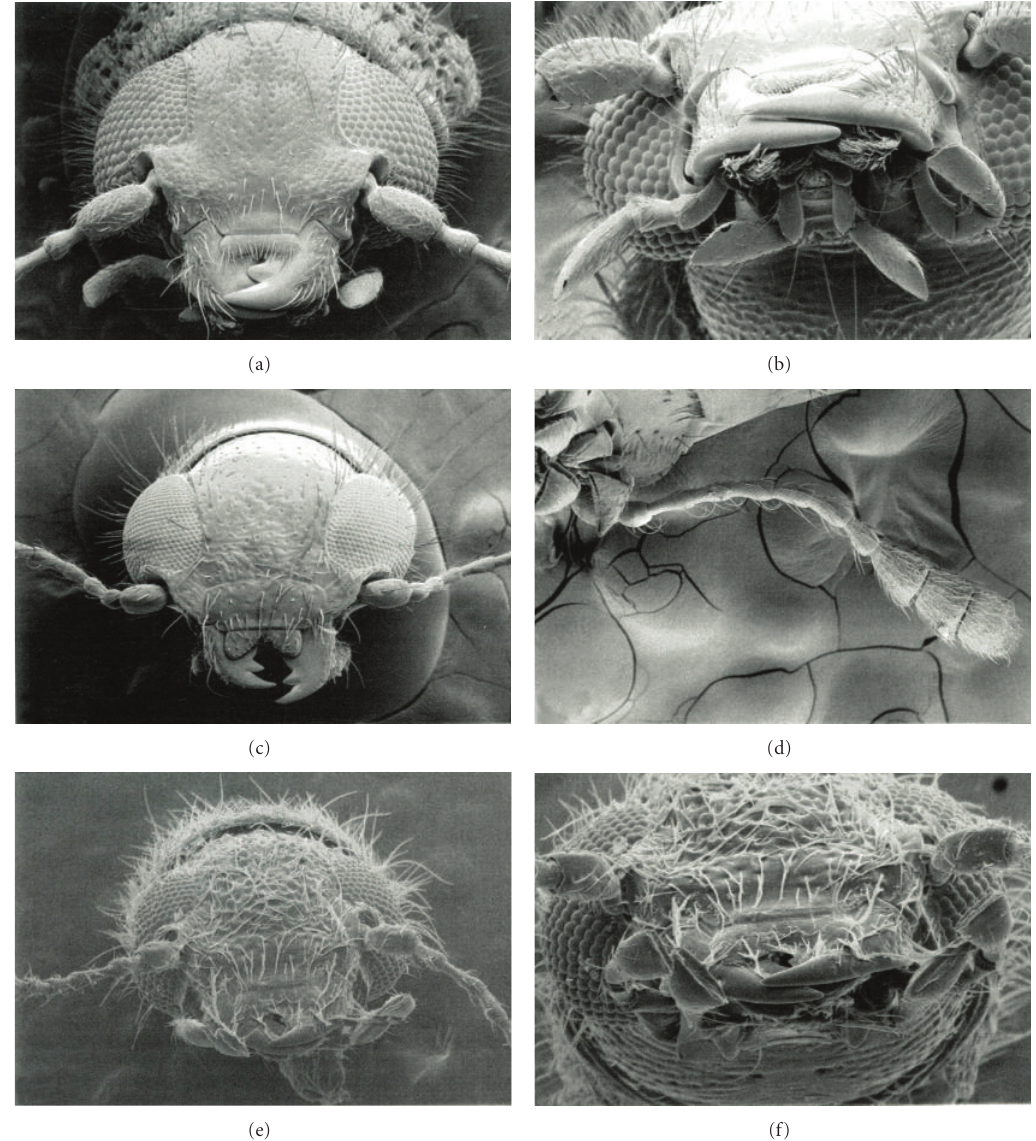
Figure 16: Various organs. (a, b) Pylus fatuus ((a) head, (b) mouthparts). (c, d) Rhophaloclerus coquerelli ((c) head, (d) antenna). (e, f) Riotenerus fossipenneus ((e) head, (f)